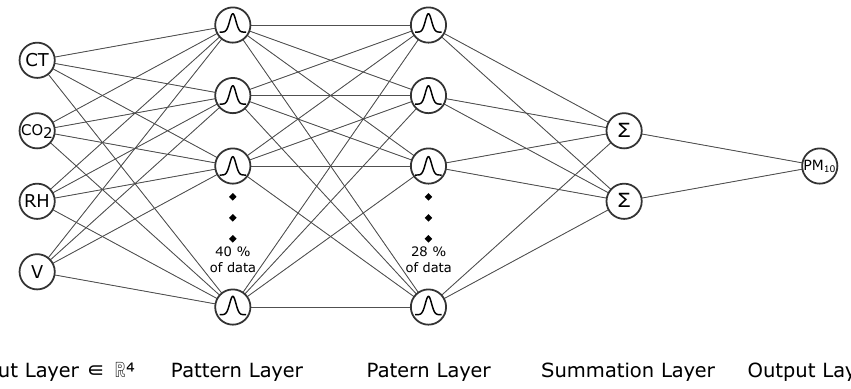
Figure 7. Probabilistic Neural Network (PNN) schematic with 4 inputs and 2 pattern layers. Last, Long Short-Term Memory (LSTM), a deep learning algorithm, is used in this study, the data from the aforementioned parameters are used as input variables, 1 dense layer with 25 LSTM Blocks and the particulate matter PM10 as output variables. Figure 8 shows the schematic of the LSTM model for this